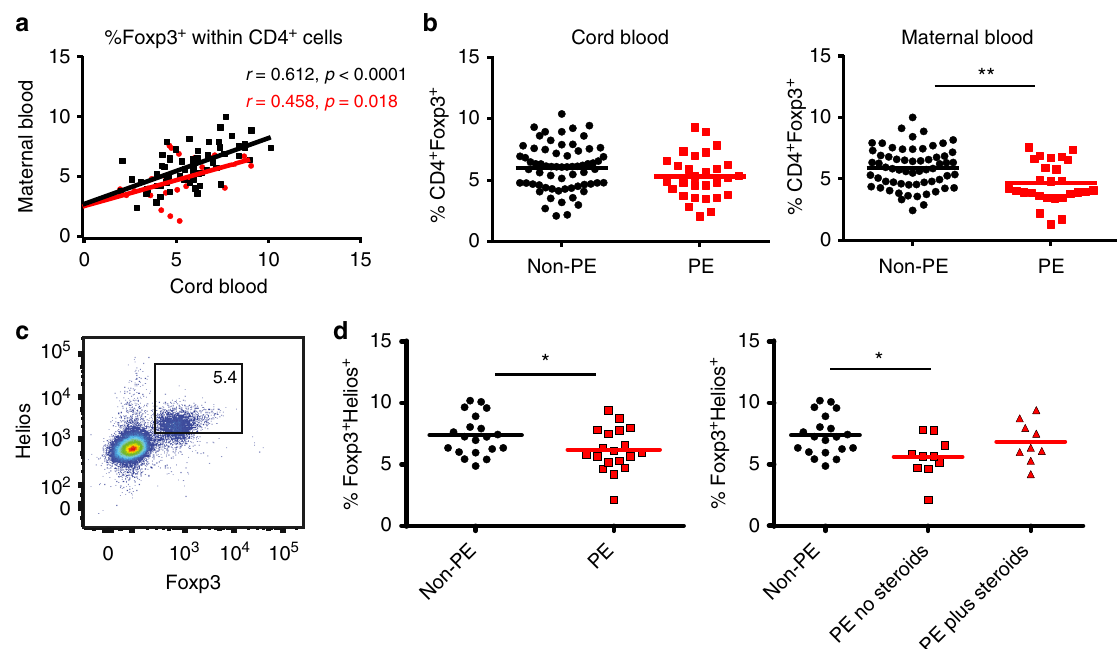
Fig. 2 Reduced number of fetal Treg cells and fetal Treg thymic output in preeclampsia. Nepean cohort 3 : a Scatter dot plot showing Treg cell frequencies in term maternal-fetal dyads in both non-preeclamptic (non-PE) ( n = 62, black dots) and preeclamptic (PE) pregnancies ( n = 26, red dots). Pearson ’ s correlation was used. Coef fi cient r and p- values as indicated. b Scattered dot plots comparing the %Foxp3 + (Mean) within CD4 + cells in cord blood ( n = 66 for non-PE, n = 29 for PE group) and maternal blood ( n = 62 for non-PE group, n = 27 for PE group) (unpaired t -test). Gating strategy for Foxp3 + Tregs from PBMC is shown in Supplementary Fig. 2. c Representative dot plot showing cord blood Foxp3 + Helios + cells gated on CD4 + cells. d Scattered dot plots showing the percentage of Foxp3 + Helios + cells (Mean) in cord blood. Left panel comparing %Foxp3 + Helios + cells in non-PE ( n = 20) and PE ( n = 19) groups (unpaired t -test). Right panel dividing the PE group into two subgroups based on steroids treatment: n = 10 for no Steroids and n = 9 for plus Steroids (one-way ANOVA with Dunnett ’ s multiple comparisons test). * p < 0.05, ** p < 0.01